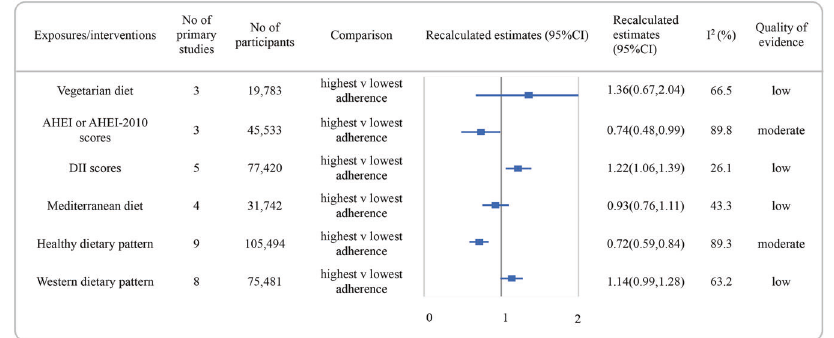
Fig. 2 Summary estimates with 95% con fi dence intervals and quality of evidence for the associations between dietary patterns or dietary quality indices and the risk of depression. AHEI alternate healthy eating index, DII dietary in fl ammatory index, CI con fi dence interval.